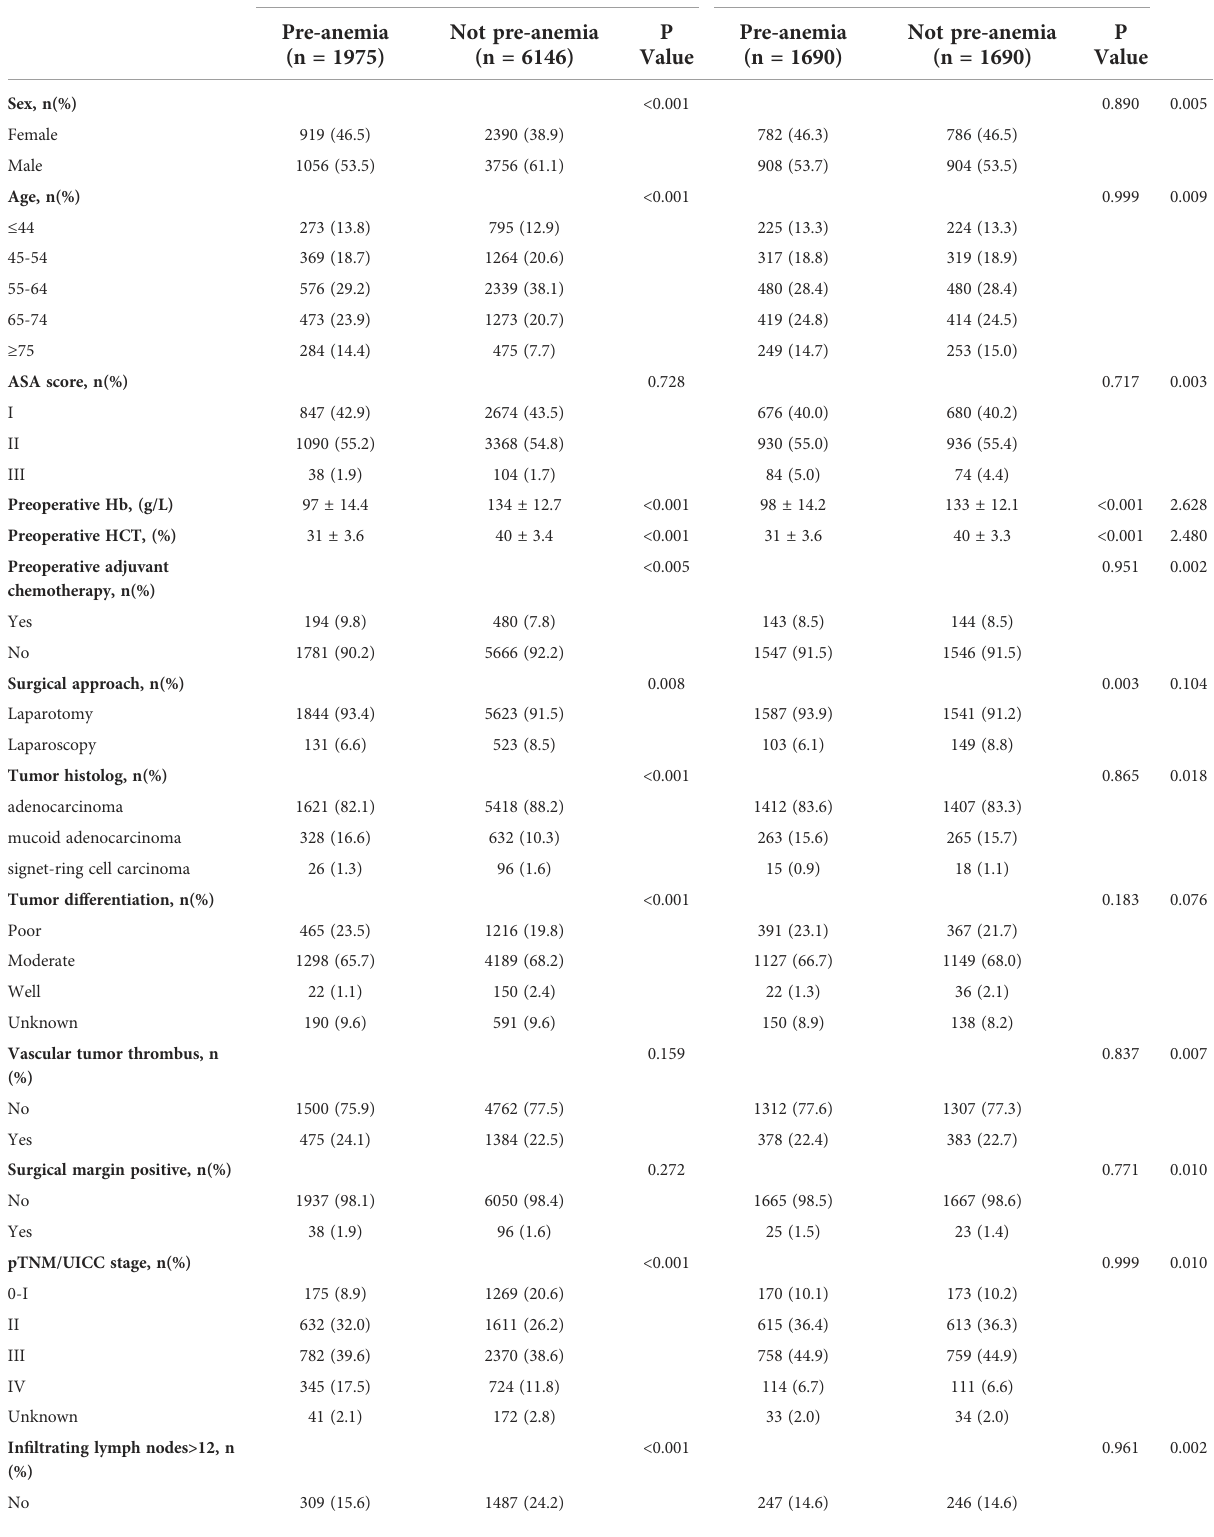
TABLE 1 Patient baseline characteristics in the total study cohort and the Propensity score